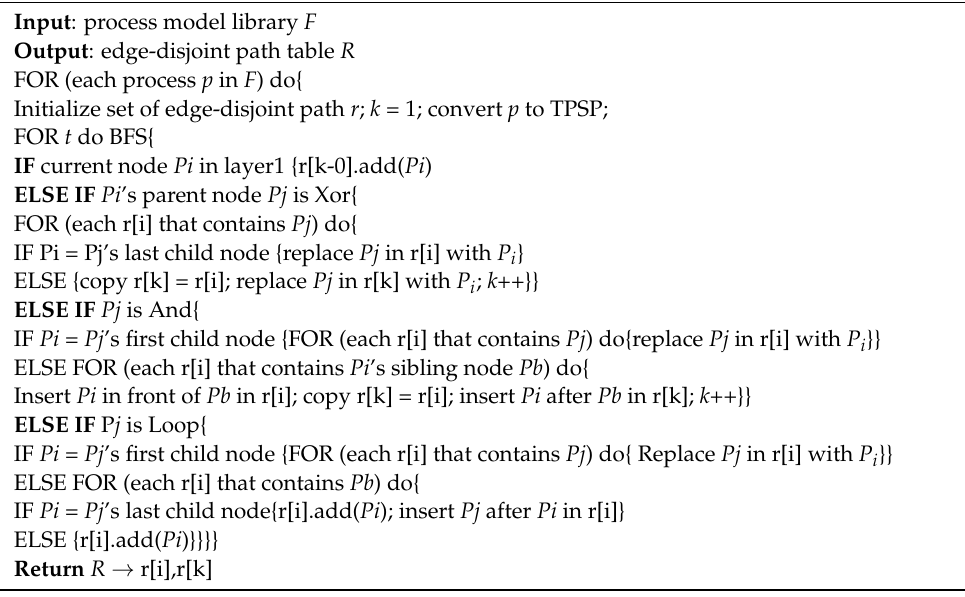
Algorithm 1. EPE for the process model